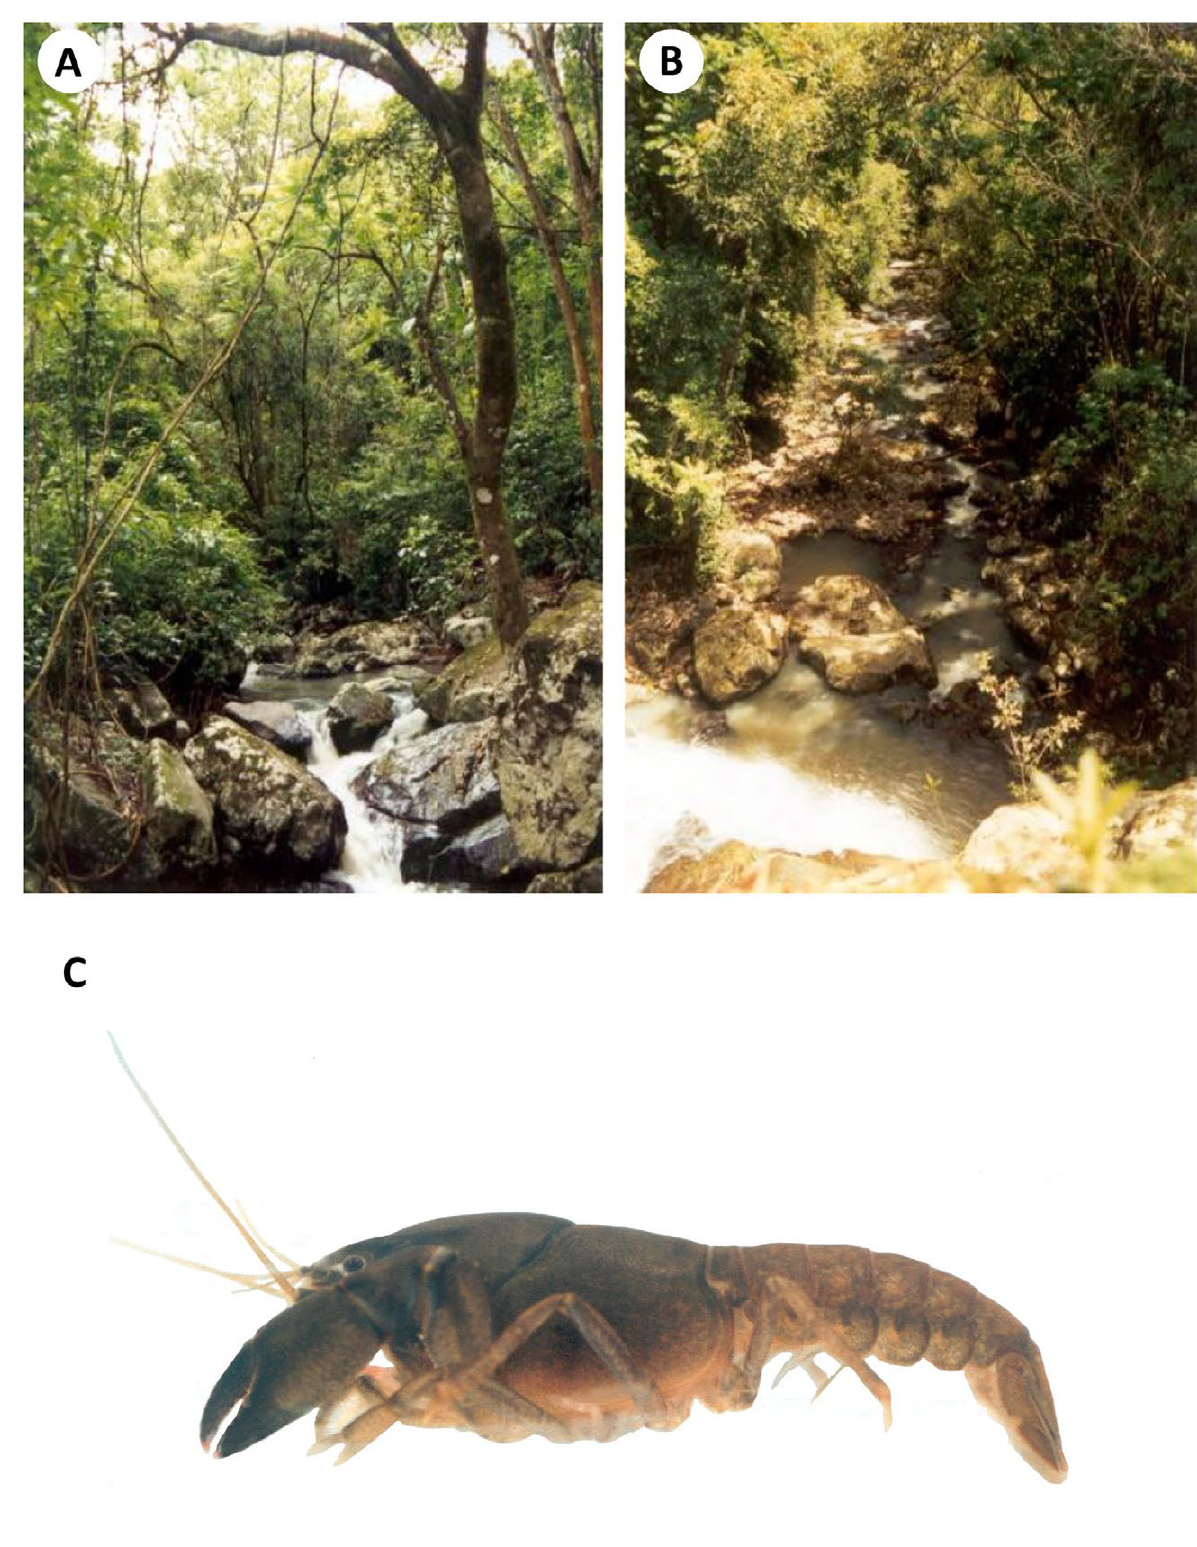
Figure 3. Parastacus buckupi sp. nov, habitat and living specimens. A, B, Typical habitat, a first order stream at Maquiné, state of Rio Grande do Sul; C, living specimen, habitus, dorsal view. Photographs by Fábio S. Vilella. No available information of scale in photograph